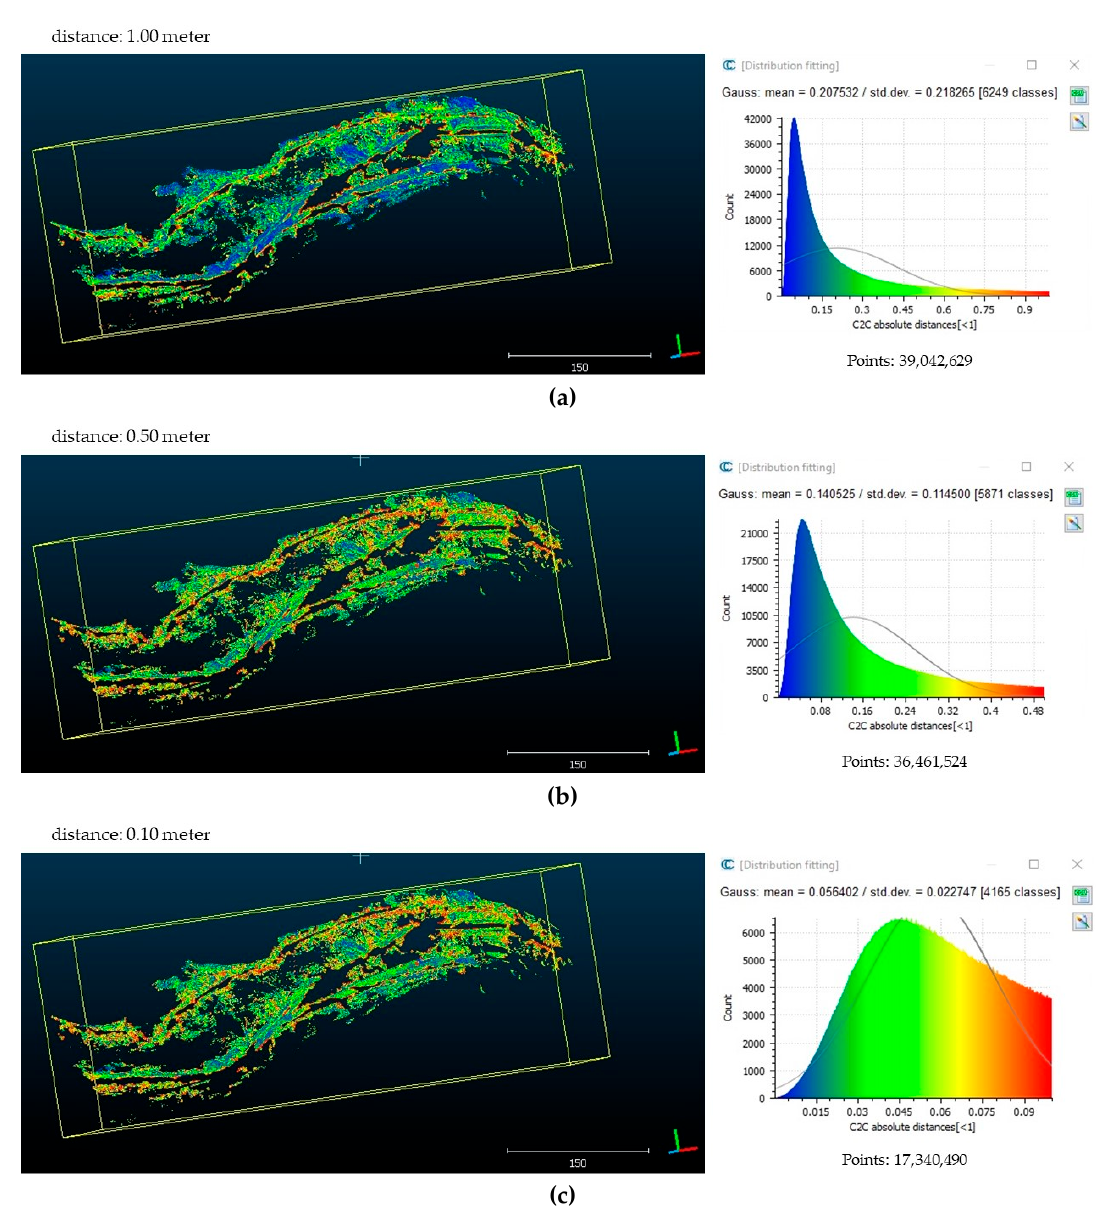
Figure 13. Cloud-to-cloud (C2C) processing between CRP and MMS point clouds at different values of distances: ( a ) 1 m, ( b ) 0.50 m, ( c ) 0.10 m.